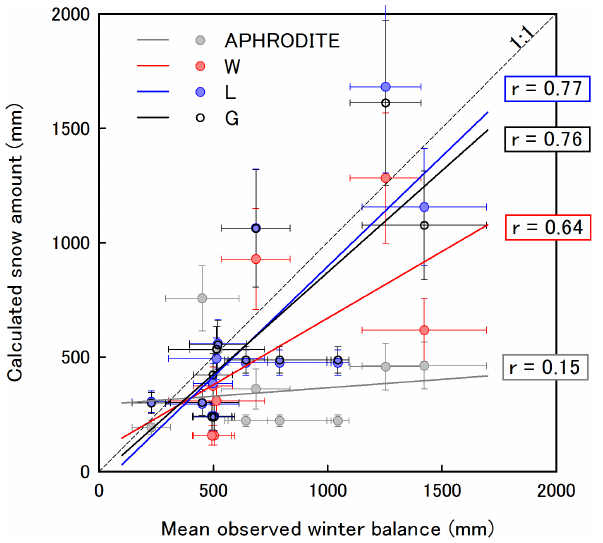
Figure 7. Relation between observed winter balance averaged from 1979 to 2000 and calculated snow amounts. Grey circles indicate the snow amounts calculated from APHRODITE. Hollow small cir- cles, blue circles, and red circles show those snow amounts calcu- lated from precipitation based on G-average elevation, L-average elevation, and W-average elevation, respectively. Both vertical and horizontal error bars indicate standard deviation of each annual value. RMSE, correlation coefficient, and significance level be- tween observed data and calculated snows are listed in Table S3.